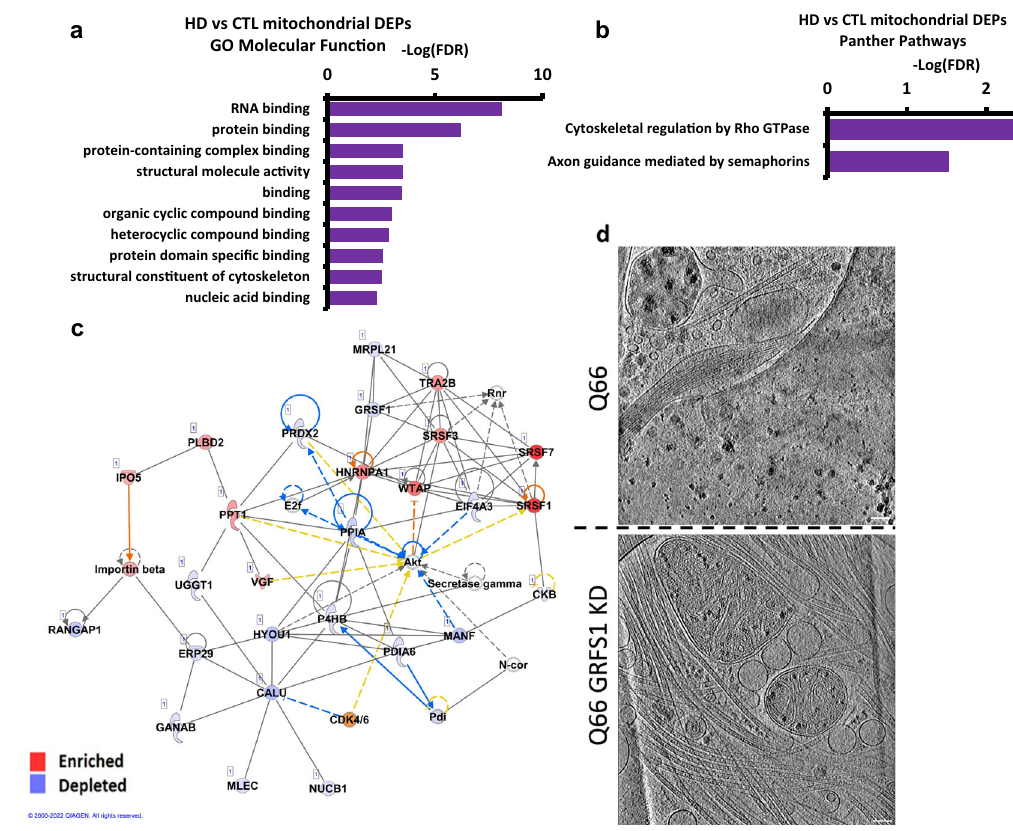
Fig. 7| AnalysisofmassspectrometrydatafromisolatedHD(Q109)vscontrol mitochondria indicates RNA binding and knockdown of RNA binding protein GRSF1 inQ66reducesmitochondriagranulesize.a Graphofgeneontology(GO) analysis of the 124 unique of differentially enriched proteins in HD vs control mitochondriashowingmolecularfunctionsoverrepresentedbyHDDEPs.Thefalse DiscoveryRate (FDR) indicates the reliability ofthe functionalidenti fi cationof the DEPs. b Graph of Panther analysisof the 124 differentially enrichedproteins in HD vs control mitochondria showing Panther Pathways overrepresented by HD